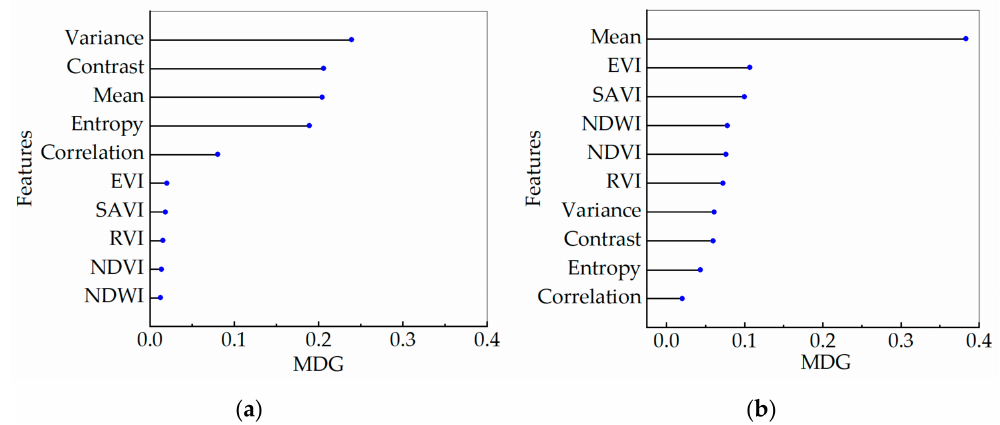
Figure 8. Comprehensive importance of each feature of nine temporal images. ( a ) Model 1 and ( b ) Model